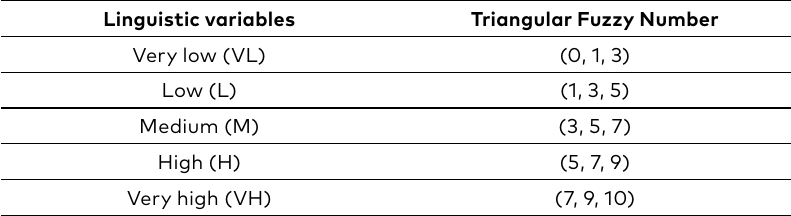
Table 6. The Triangular Fuzzy Numbers related to linguistic variables. Linguistic variables Triangular Fuzzy